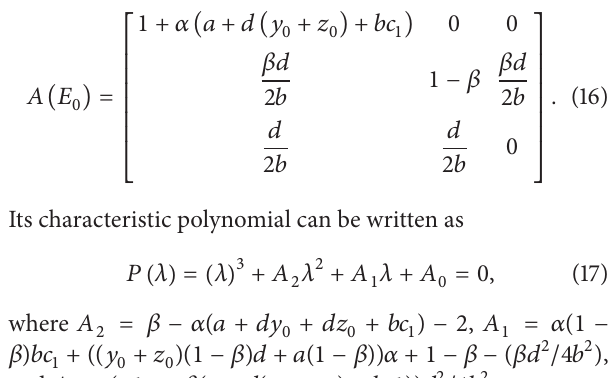
(𝑠 , 𝑠 ) and Ω (𝑠 , 𝑠 ) show that the price 2 3 𝐸 1 2 3 0